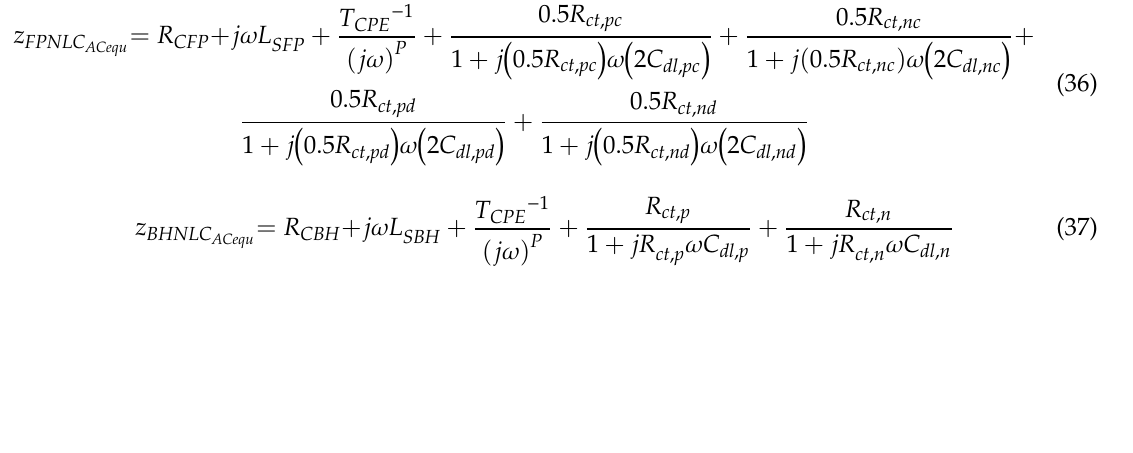
Figure 19. Experimental Nyquist curve is fitted by FPNLC ACequ and BHNLC ACequ . Table 3. Values of elements in Figure 18.